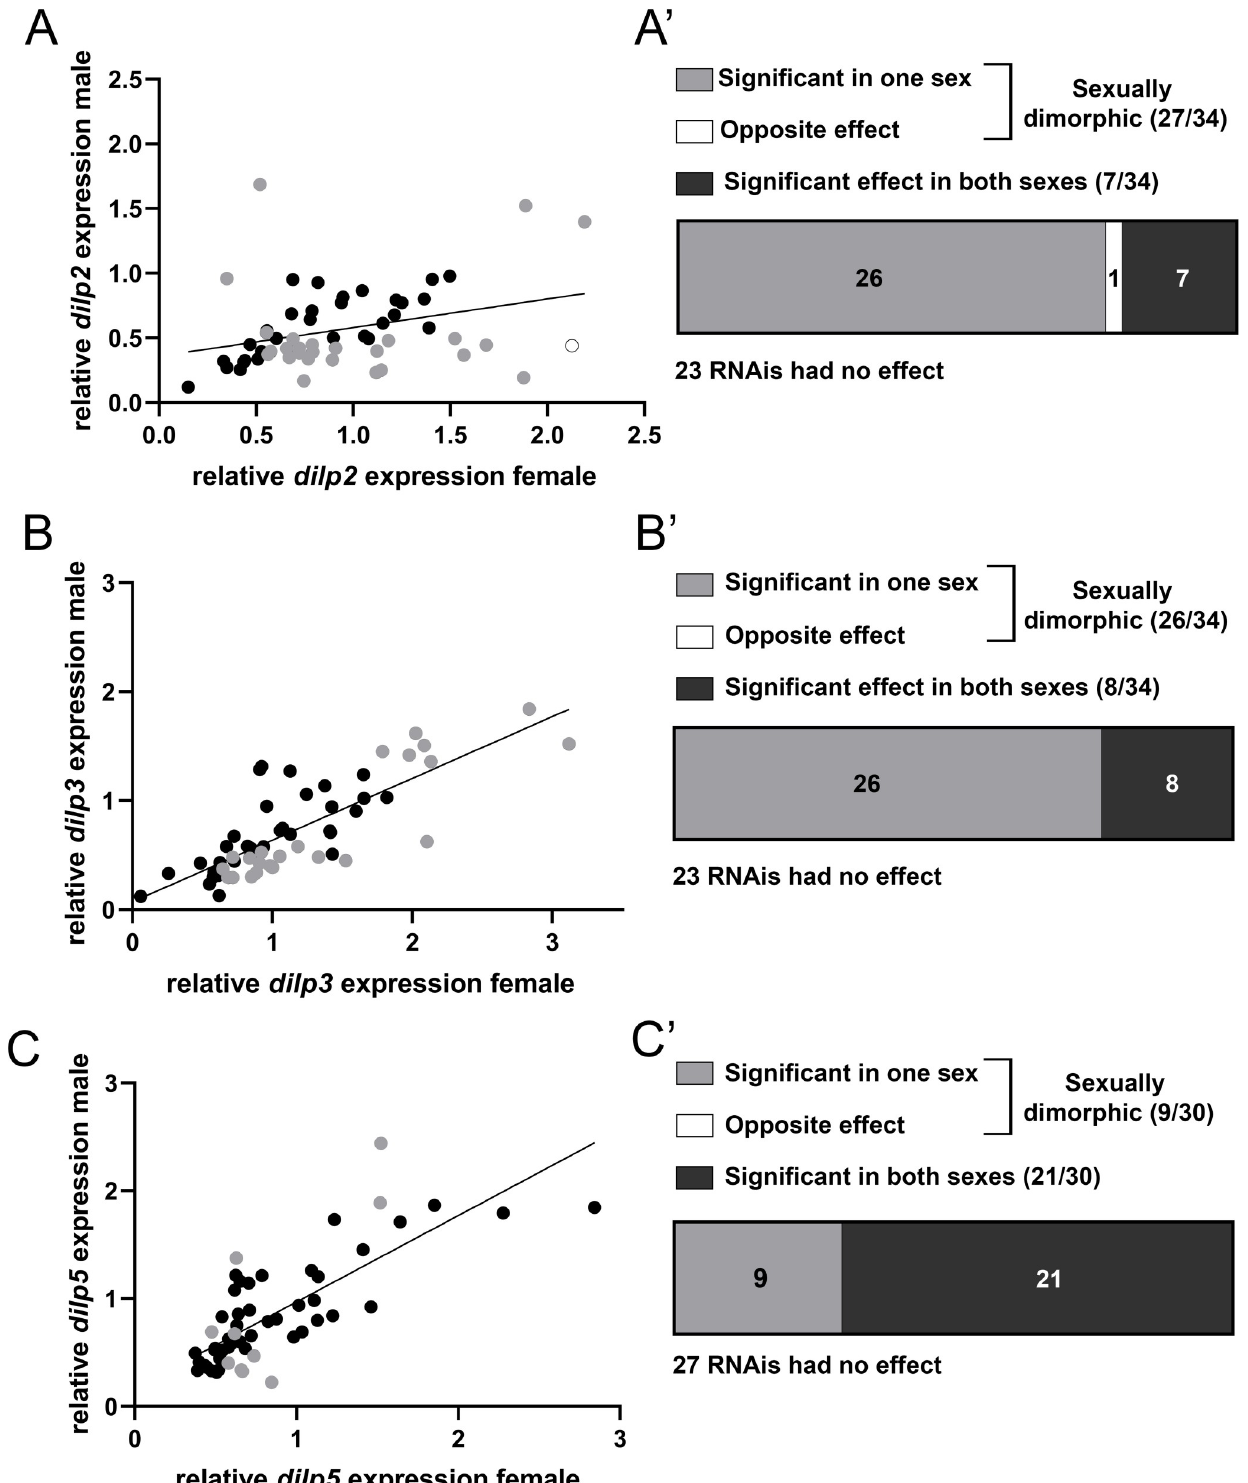
Fig 2. Knockdown of candidate genes in the IPCs produces correlated effects on dilp expression between the sexes. (A) The mean relative quantity of dilp2 upon RNAi-mediated knockdown in the IPCs between female and male flies is mildly correlated (Spearman r = 0.3467, p = 0.0081). (A’) Out of 57 tested genes, 27 had sexually dimorphic effects on dilp2 expression, one ( Ldsdh1 ) having opposite effects on dilp2 expression. 30 genes had no effect (23) or